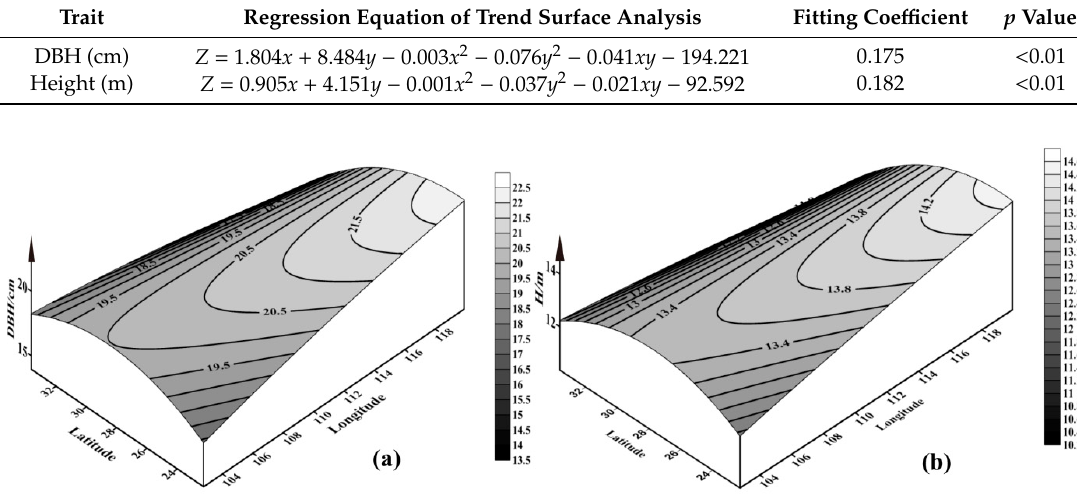
Figure 3. Diagram of two power contour-trend surfaces of DBH ( a ) and H ( b ) for Chinese fir. The surface represents the geographical variation of DBH and H, and the lines on the surface represent contours.